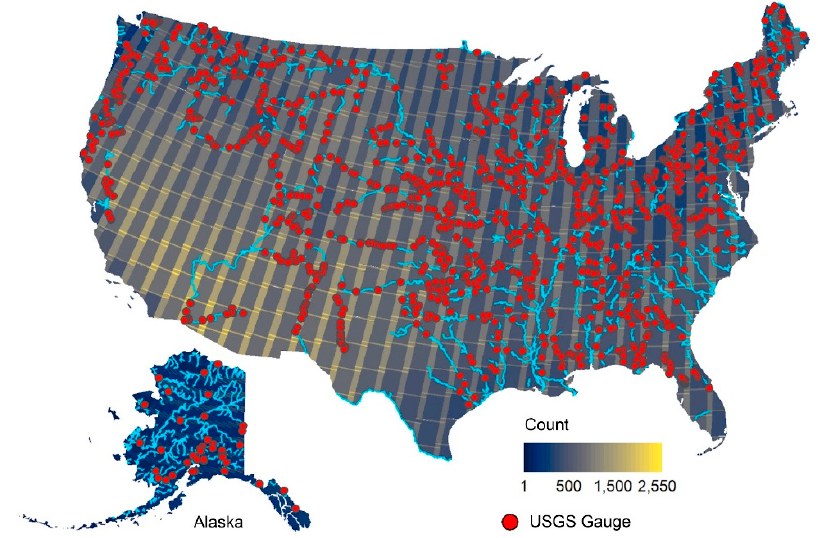
Figure 1. Map showing the United States Geological Survey (USGS) gauges used in this study and Landsat 5, 7, and 8 data availability based on the number of images with less than 30% cloud cover. Regions affected by cloud cover and low sun angle tend to have lower data availability. Rivers equal to or wider than Landsat’s 30 m resolution at mean discharge shown as blue lines [28].